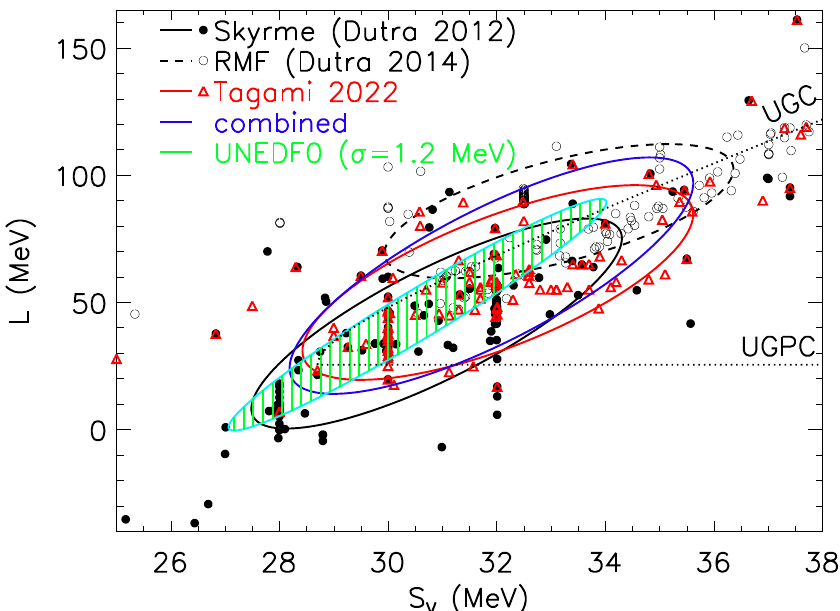
Figure 1. S V and L data from individual Skyrme (black filled circles, Ref. [34]), relativistic mean field (RMF, black open circles, Ref. [36]) forces, both interaction types (Tagami 2022, red triangles, Ref. [37]), and all tabulated interactions (combined); corresponding 68.3% confidence ellipses are shown. The green hatched confidence ellipse is taken from the UNEDF collaboration [38] using σ = 1.2 MeV (see text). The bounds provided by the Unitary Gas Conjecture (UGC, [35]) and the Unitary Gas Pressure Conjecture are shown as dotted curves.